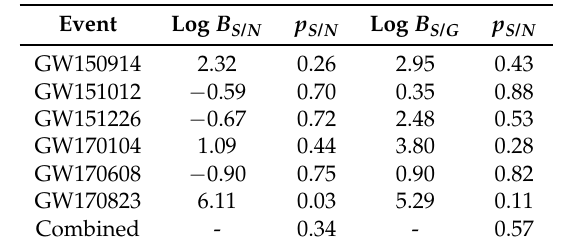
Table 20. Log Bayes factors for signal versus noise and signal versus glitch, and the corresponding p -values, for events seen in two detectors of GWTC-1 [147]. The bottom row shows the combined p -values for all these events together.